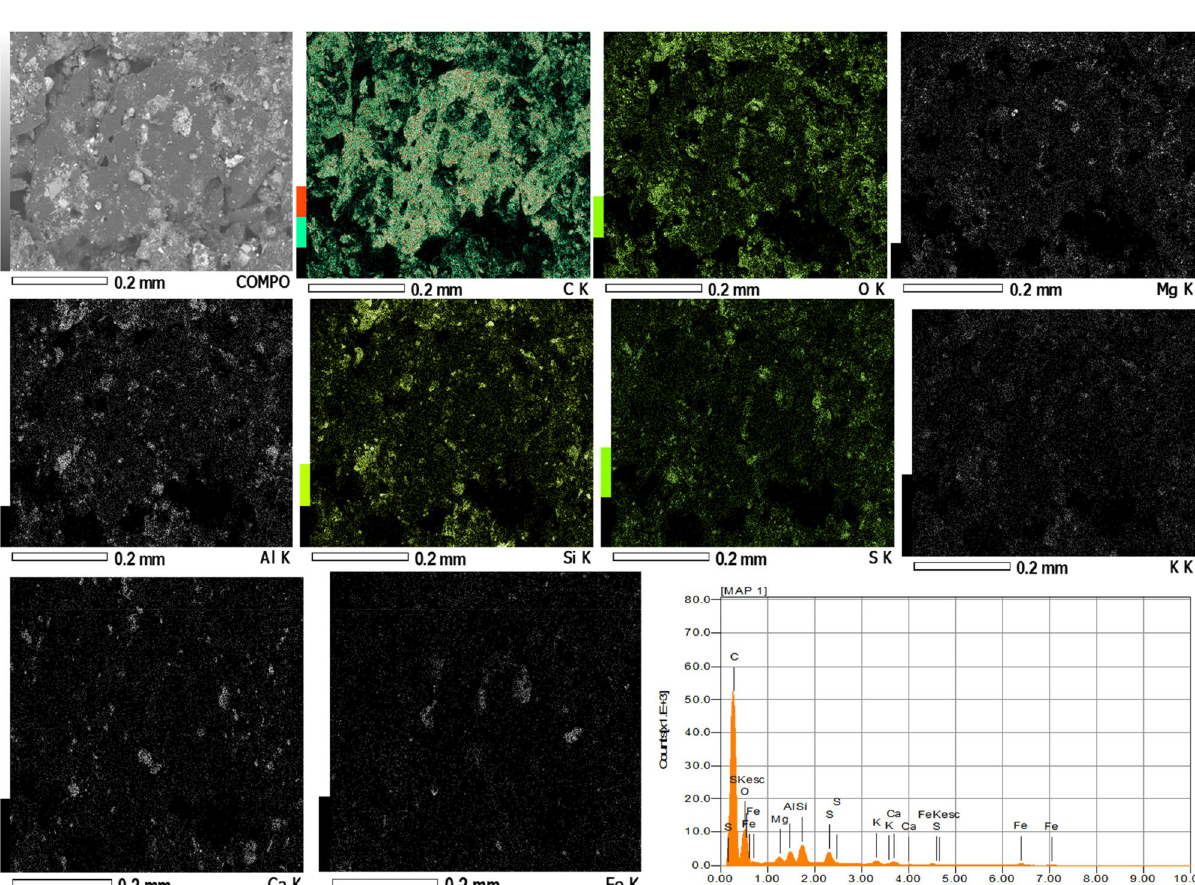
Figure 10. Elemental mapping of the briquette with 2%